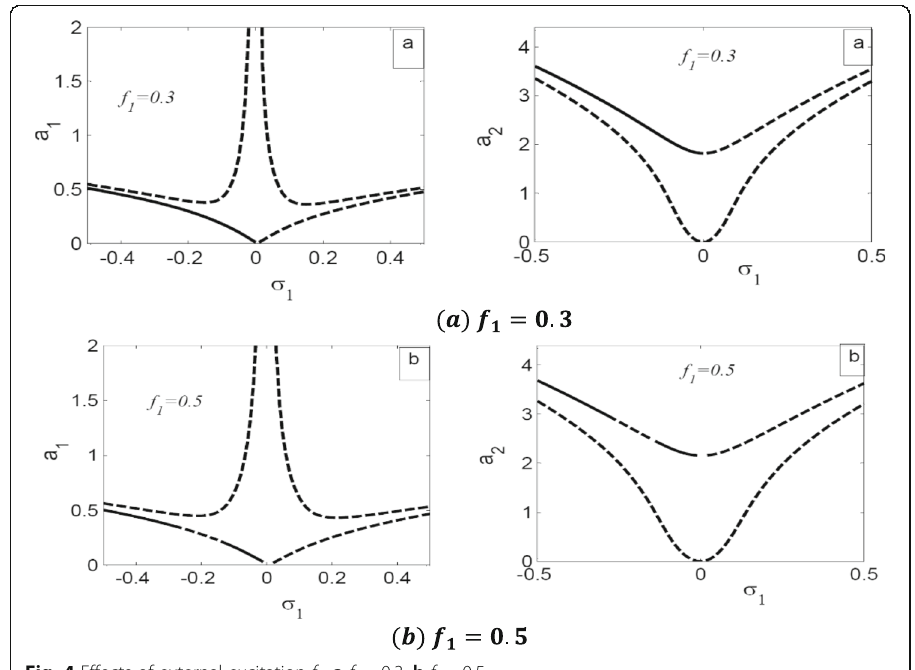
Fig. 4 Effects of external excitation f 1 . a f 1 = 0.3. b f 1 = 0.5